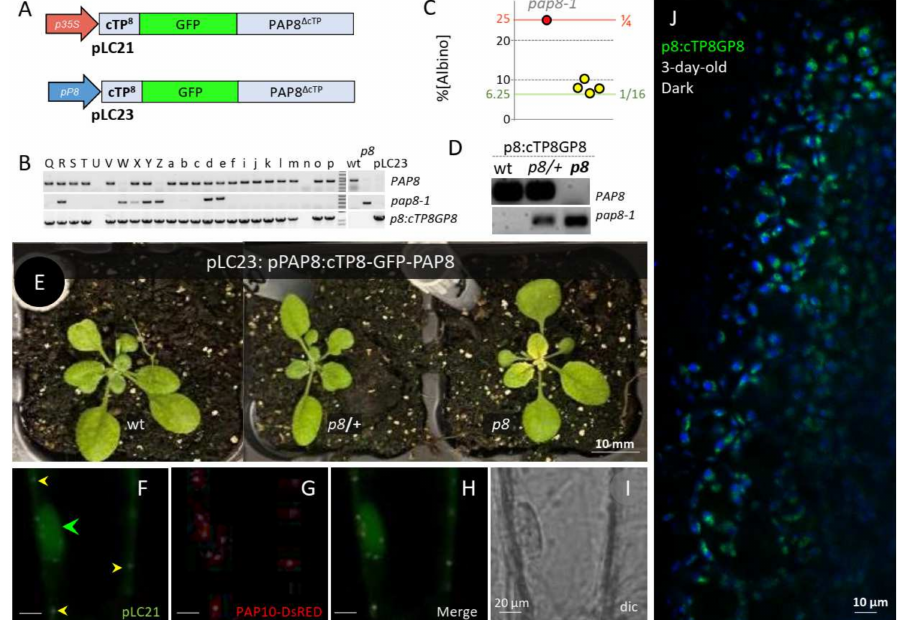
Figure 2. A PAPunctional. ( A ) Structure of the recombinant DNA for the production of GFP translational fusions p35S, CaMV35S promoter; pP8, 1-kb PAP8 promoter; cTP8, predicted chloroplast transit peptide from PAP8. ( B ) Sample DNA gels for the PCR-based genotyping of the primary transformants (T1) according to [27]; wild-type PAP8 allele, (op8_rtp_F + op8i2R); mutant allele pap8-1, (op8_rtp_F + oLBb1.3) and transgene p8:cTP8GP8, (oGFP_Fmfe + oP8E3_R). Wt, wild- type; p8, pap8-1 genomic DNA and pLC23, plasmid DNA containing the transgene. The doubly heterozygous plants have all three bands. ( C ) Dot plot of the percentage of albinos obtained in the segregating offspring from the doubly heterozygous plants as independent T1 (yellow spots). Functional complementation corresponds to a ratio of 1/16 (6.25%). ε -test, α = 0.05; Fisher Yates: the 4 tested lines Z, G , η , R in yellow circles gave a ratio not significantly different from 1/16, n[albino]/Ntotal: 27/353; 44/706; 22/284; 28/352, respectively ( ε Z = 0.989; ε G = 0.019; εη = 0.943; ε R = 1.181; all ε < U 5% = 1.96). ( D ) Single T2 plant genotyping, primers as in ( B ); all plants positive for the transgene (p8::cTP8GP8, pPAP8::cTP8-GFP-PAP8), the status is given for the PAP8 locus as follow: wt, PAP8,PAP8, p8/+, PAP8/pap8-1 and p8, pap8-1/pap8-1. ( E )